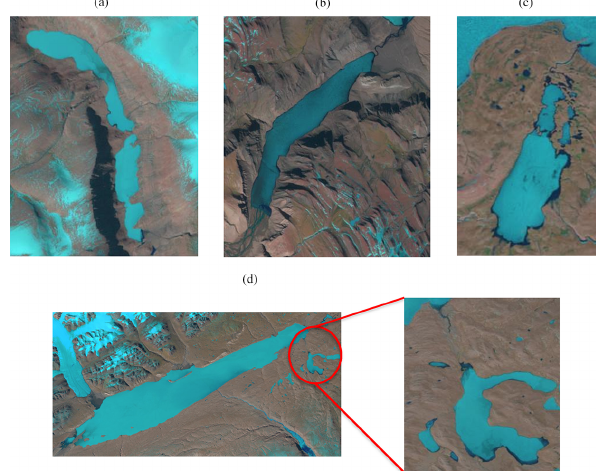
Figure 7. Landsat images acquired at the start of ice break-up show- ing melt and/or open water adjacent to water inflows: (a) Upper and Lower Murray Lakes (17 June 2007); (b) Buchanan Lake (8 July 1999); (c) Lake L6, (10 July 2003); (d) Lake Hazen and Craig Lake (16 June